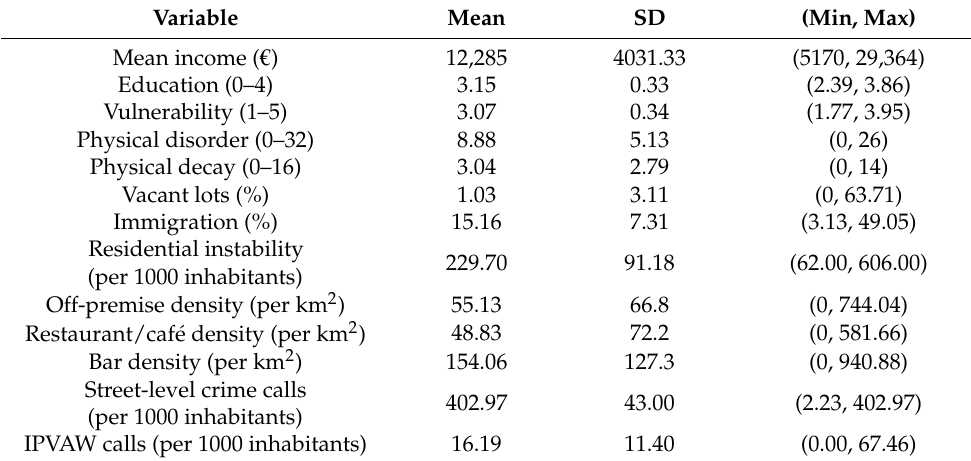
Table 1. Descriptive statistics for the outcomes and the control